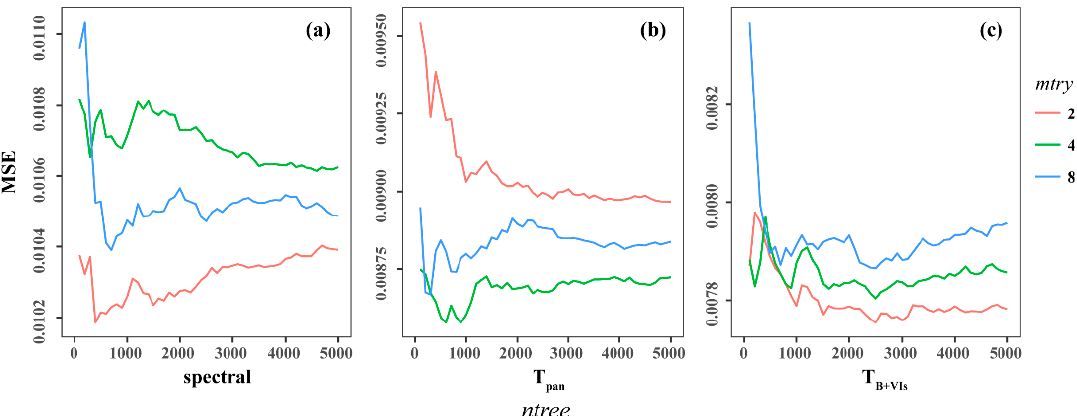
Figure 4. Effect of mtry and ntree on the random forest (RF) models of ( a ) spectral variables; ( b ) T pan ; ( c ) T B+VIs .